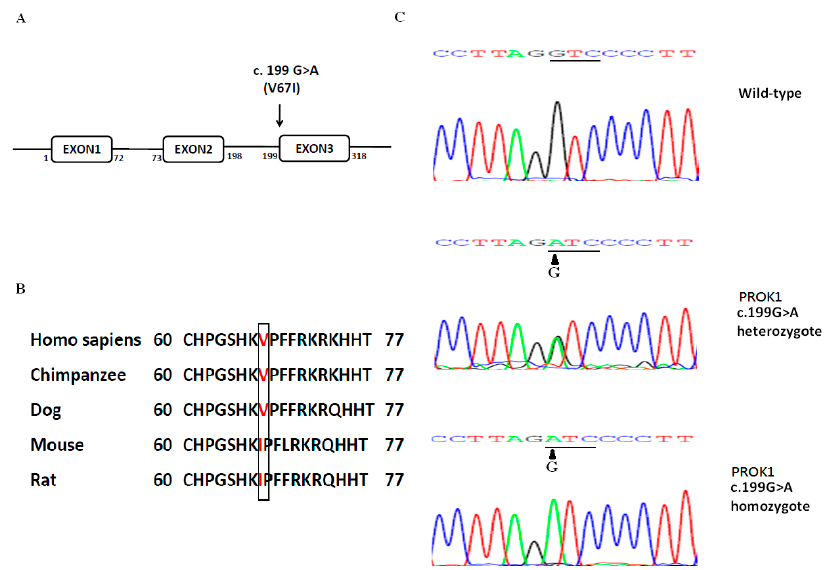
Figure 1. ( A ) Schematic of PROK1 variant (c.199G>A; p.Val67Ile); ( B ) PROK1 variant (V67I) is conserved